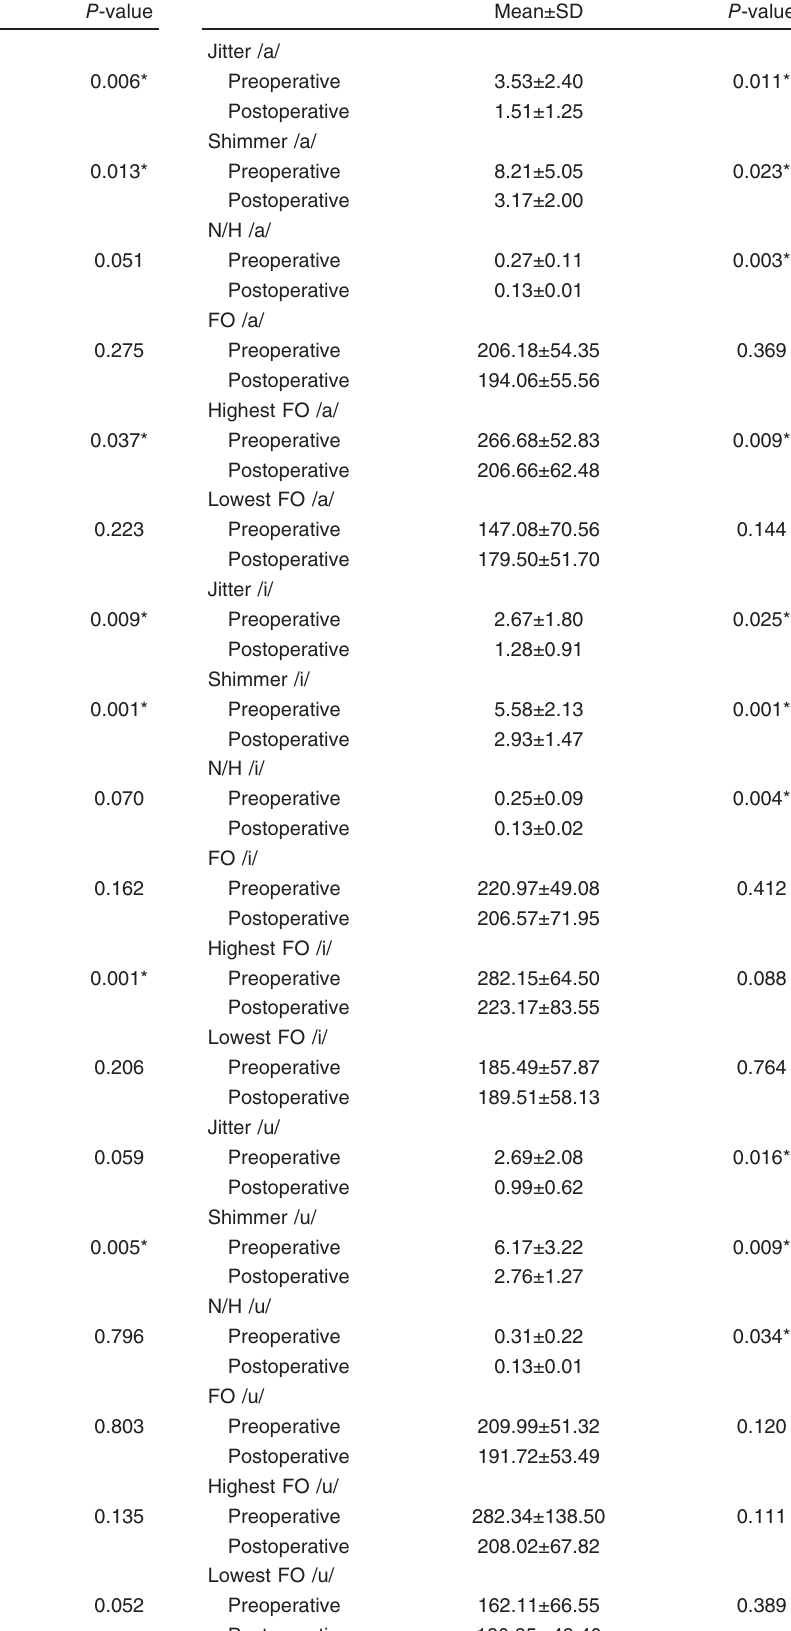
Table 9 Comparison between preoperative and postoperative data of the patients of group A (microlaryngosurgical.)